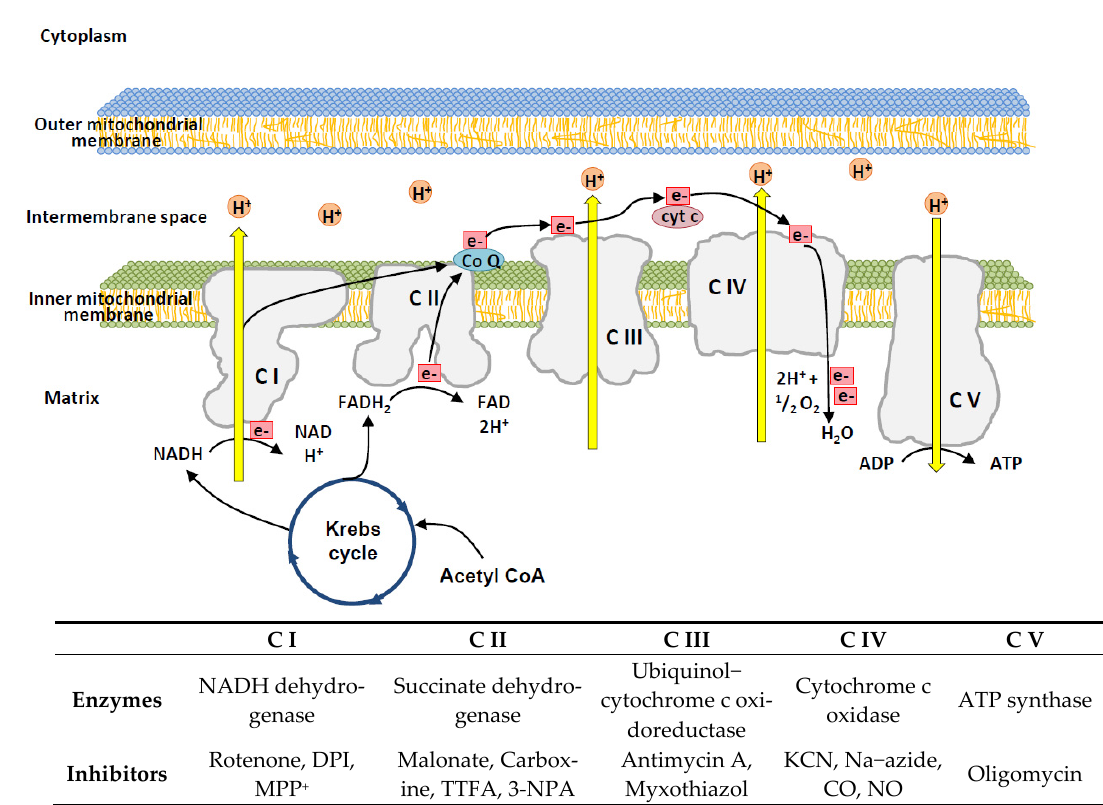
Figure 1. Schematic model of the oxidative phosphorylation (OXPHOS) process and relative in- hibitors. In the electron transport chain, the reduced substrates NADH and FADH 2 are oxidized by NADH − ubiquinone oxidoreductase and succinate − CoQ reductase, respectively. Finally, cytochrome c oxidase reduces molecular oxygen to water using electrons from reduced cytochrome c. The Krebs cycle is one of the main suppliers of redox equivalents. OXPHOS inhibitors are shown in the lower box. 3-NPA, 3-nitropropionic acid; ATP, adenosine triphosphate; C I, Complex I; C II, Complex II; C III, Complex III; C IV, Complex IV; C V, Complex V; CO, carbon monoxide; CYTC, cytochrome c; CoQ, coenzyme Q10; DPI, diphenyleneiodonium; KCN, potassium cyanide; MPP, 1-methyl-4- phenylpyridinium; Na − azide, sodium azide; NADH, nicotinamide adenine dinucleotide; NO, nitric oxide; TTFA, thenoyltrifluoroacetone.